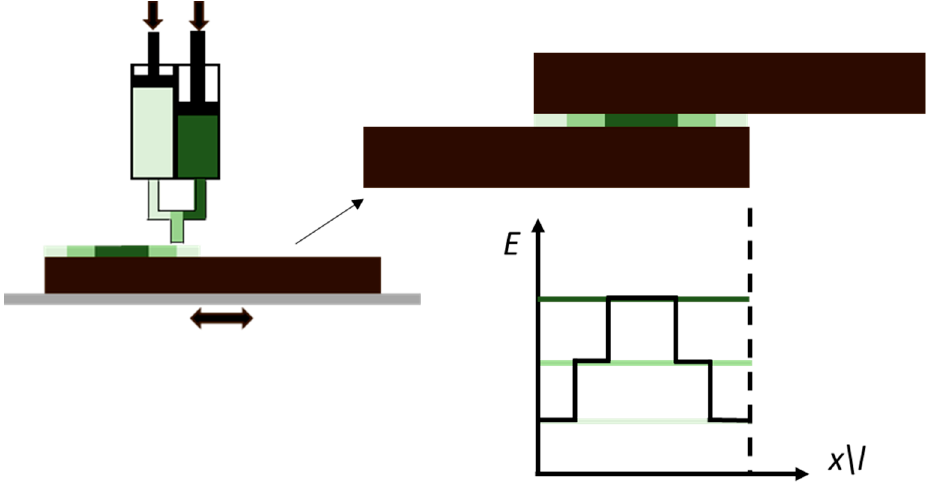
Figure 9. Adhesive modulus tailoring using a stepwise design strategies and second generation acrylic adhesives [43].